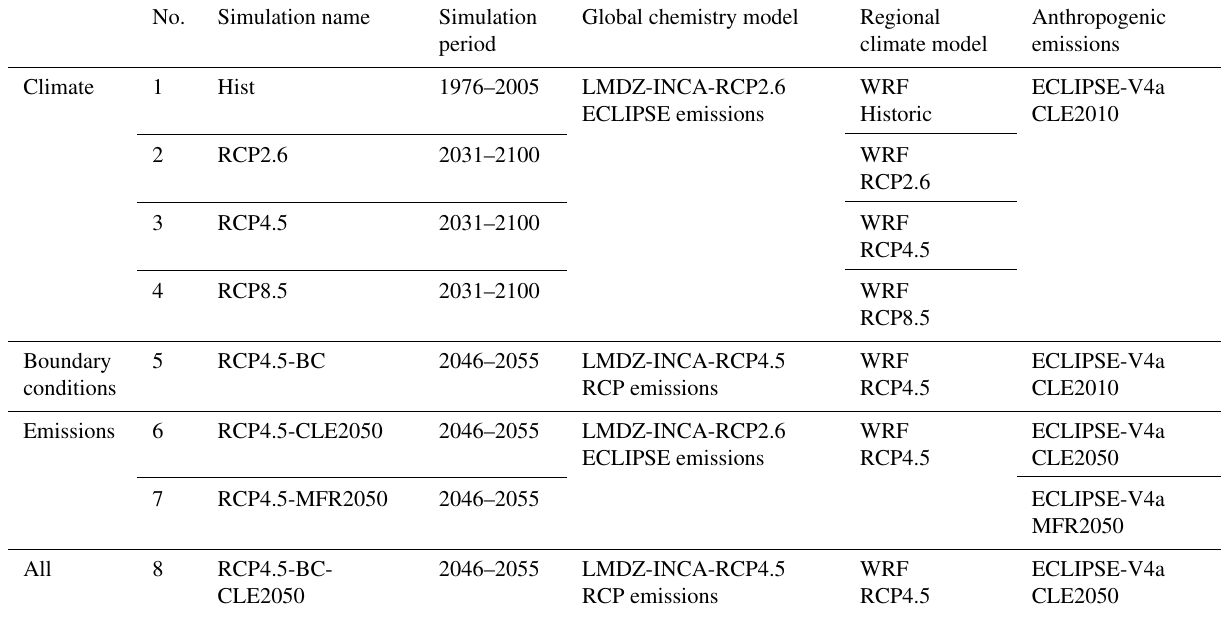
Table 1. The different scenarios used in this